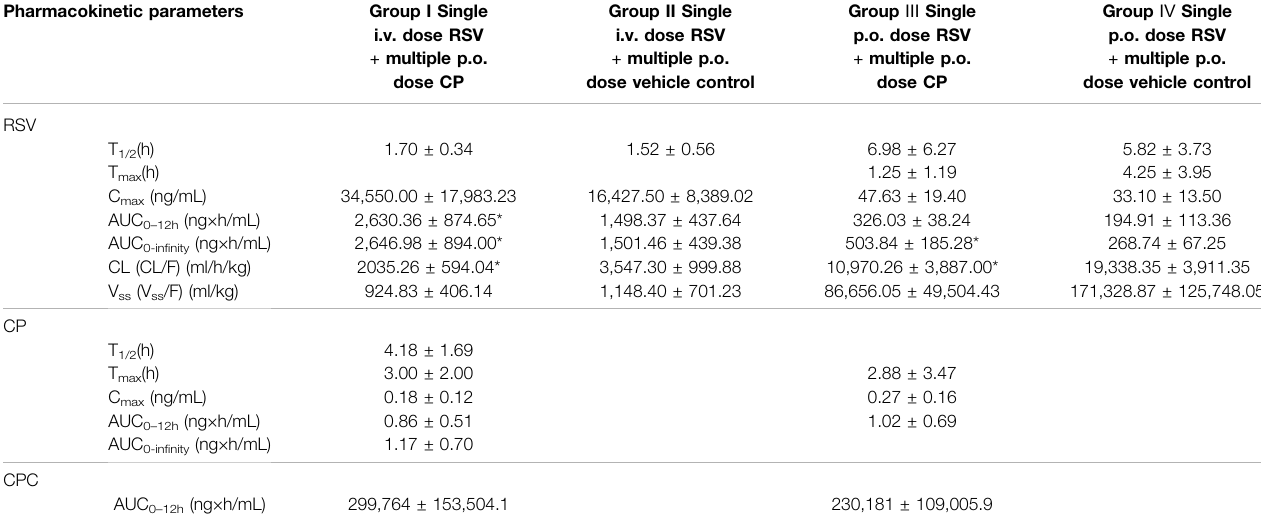
TABLE1| PharmacokineticparametersofRSV,CP,andCPCinthepresenceandabsenceofCP.Dataarepresentedasmean ± S.D.(n (cid:2) 4).* p < 0.05whencomparedwith the respective single dose RSV group. The rats were randomly assigned into four groups (n (cid:2) 4, each group, group I to IV) and each group received a p.o. dose of CP (27 mg/kg) or the same volume of vehicle control for 20 days. On day 21, rats in group I were treated with a p.o. dose of CP at 27 mg/kg and a single i.v. dose of RSV at 5 mg/kg. Rats in group II were treated with a p.o. dose of vehicle control and a single i.v. dose of RSV at 5 mg/kg. Rats in group Ⅲ were treated with a p.o. dose of CP at 27 mg/kg and a p.o. dose of RSV at 5 mg/kg. Rats in group Ⅳ were treated with a p.o. dose of vehicle control and a p.o. dose of RSV at 5